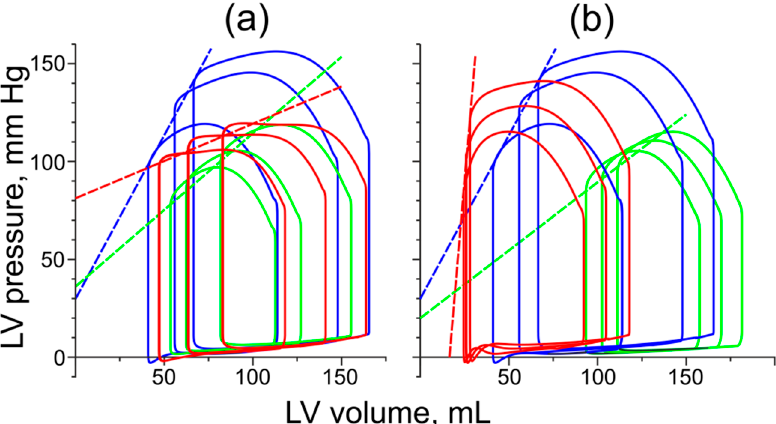
Figure 6. The LV pressure–volume loops obtained from the simulation of the LV with normal cardiac muscle and normal geometry (blue) and the simulations of DCM (green) and HCM (red). Different loops were obtained at different preloads. ( a ) PV loops obtained with normal LV geometry; ( b ) PV loops obtained for the remodeled LVs with DCM and HCM at default passive myocardial stiffness. The dashed straight lines are the ESPVR lines plotted for each simulation case.